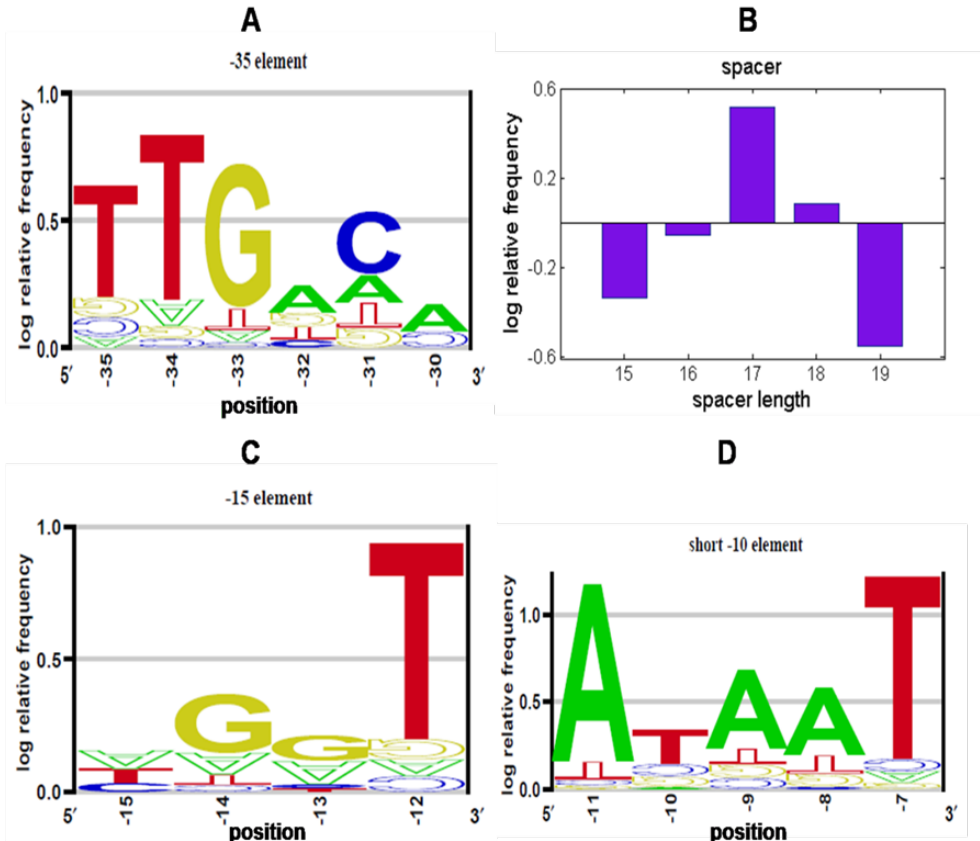
Figure 1: Logarithm of the ratio of the base frequencies in the alignment, relative to the background base frequencies is shown in the figure. For spacers (Figure 1B), log ratios are also presented, where the background distribution is equiprobable. Sequence logos correspond to specificities of A) -35 element B) Spacer between -35 and -10 element C) -15 element D) short -10 element. Figure adapted from